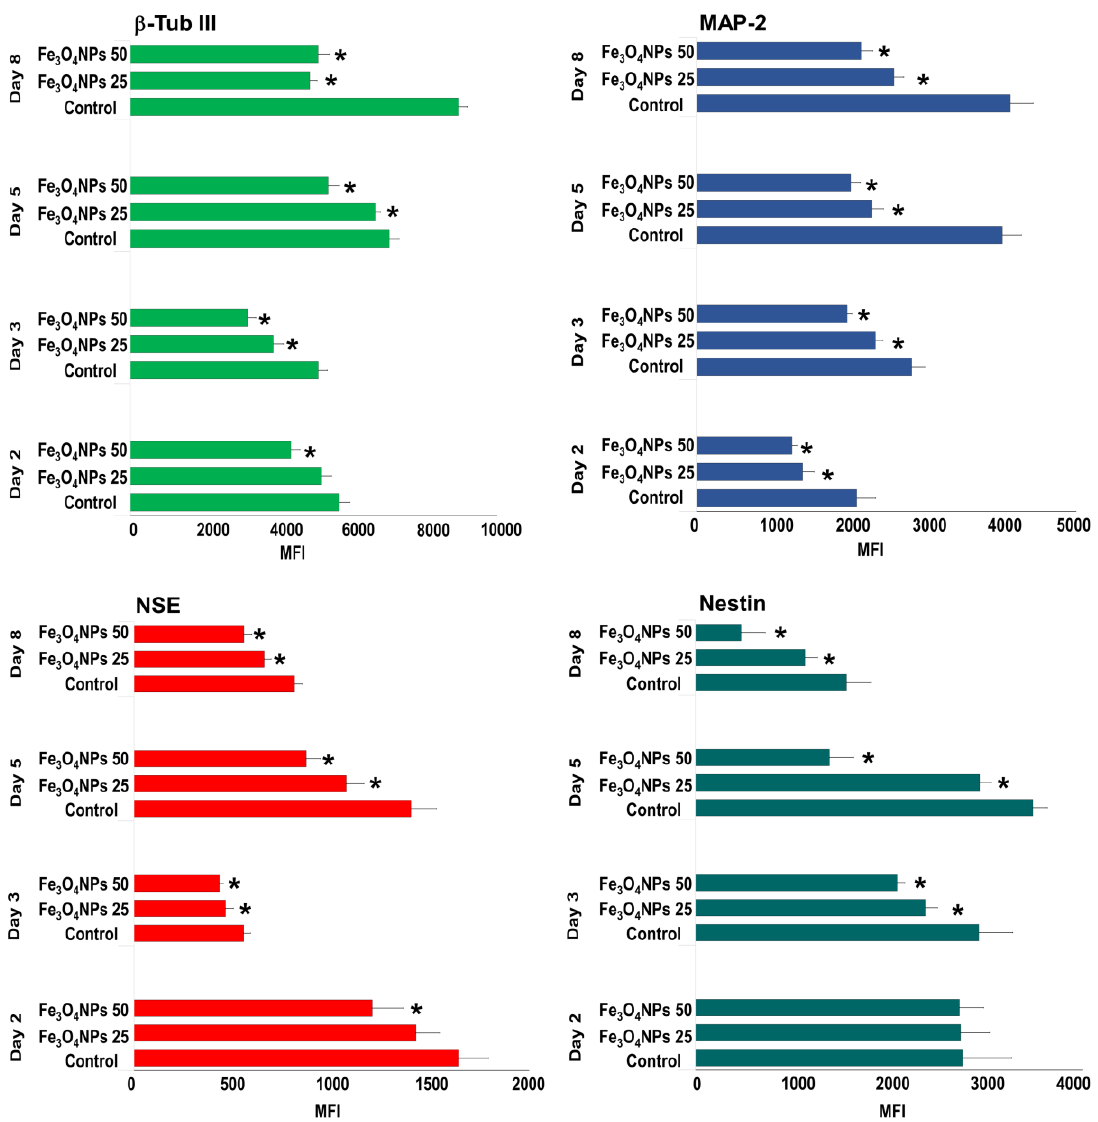
Figure 8. Flow cytometric analysis of the expression of neuronal markers over time in hNCLs untreated and exposed to Fe 3 O 4 NPs. Data are expressed as MFI and represent the mean ± S.D. * p < 0.05, statistical analysis by two-way ANOVA followed by Dunnett’s